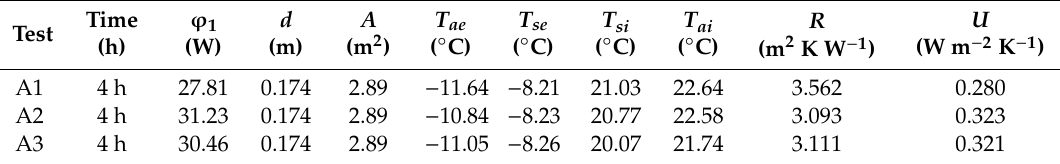
Table 4. Thermal transmittance and thermal resistance of sandwich panel filled with short-cut rapeseed insulation under steady-state